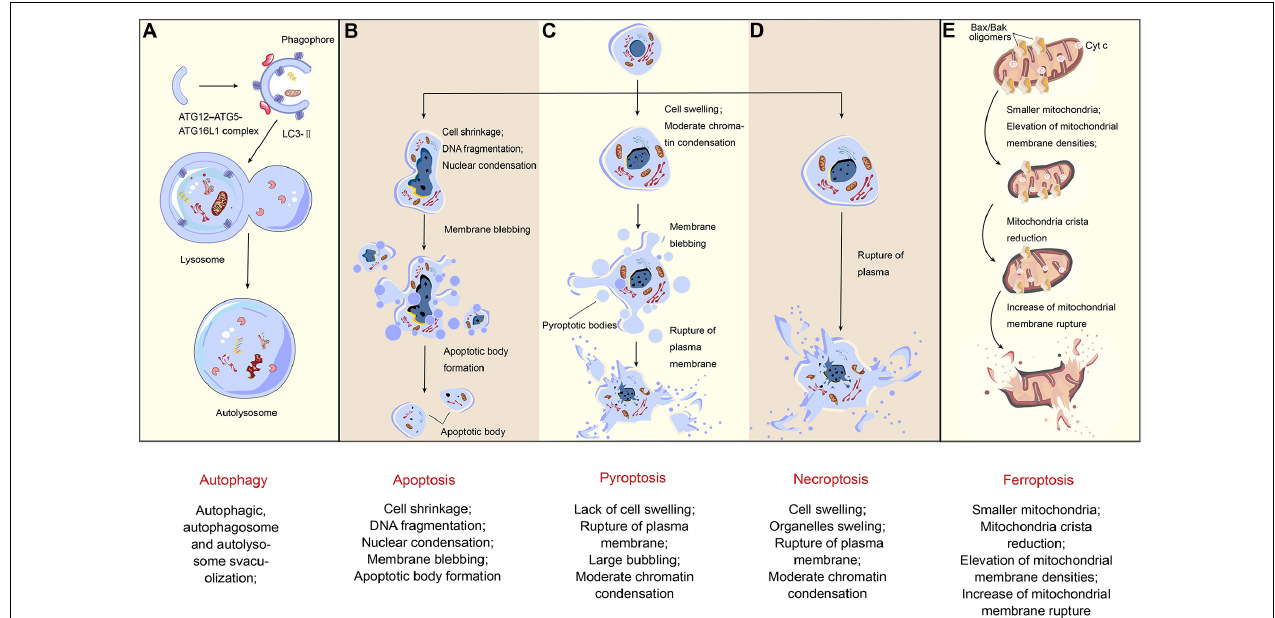
FIGURE 2 | Morphological changes of regulated cell death. Different types of cell death inducing with various pathways present diverse morphological changes. (A) The formation of autophagosomes is the typical characteristic of autophagy. ATG12-ATG5-ATG16L1 complex and LC3-II contribute to the extension of the phagophore. When the autophagosome is completely formed, LC3-II will separate from the outer membrane, and the autophagosome fuses with the lysosome so that an autolysosome finally emerged. (B) As for apoptosis, in the early stage, the nuclear condensation starts with cell shrinkage. During later stages, nucleus breaks up and the plasma membrane bubbles with no rupture, naturally associating with no inflammation. Finally, it forms apoptotic bodies. (C) Being different from apoptosis, after cell swelling and large bubbling, pyroptosis has plasma membrane rupture in the final stage. (D) When it comes to necroptosis, the appearance of cell swelling often followed by organelles dilation, and the nucleus disintegrates late. In some cases, chromatin condensation also occurs. Finally, with the rupture of plasma, a massive inflammation in the tissue is triggered. (E) The morphological characteristics of ferroptosis, however, mainly reflects on the changes of mitochondria. Compared with organelles swelling in necroptosis, here in the first stage, the mitochondria become smaller and membrane densities are elevated, followed by mitochondria crista reduction and plasma membrane rupture.